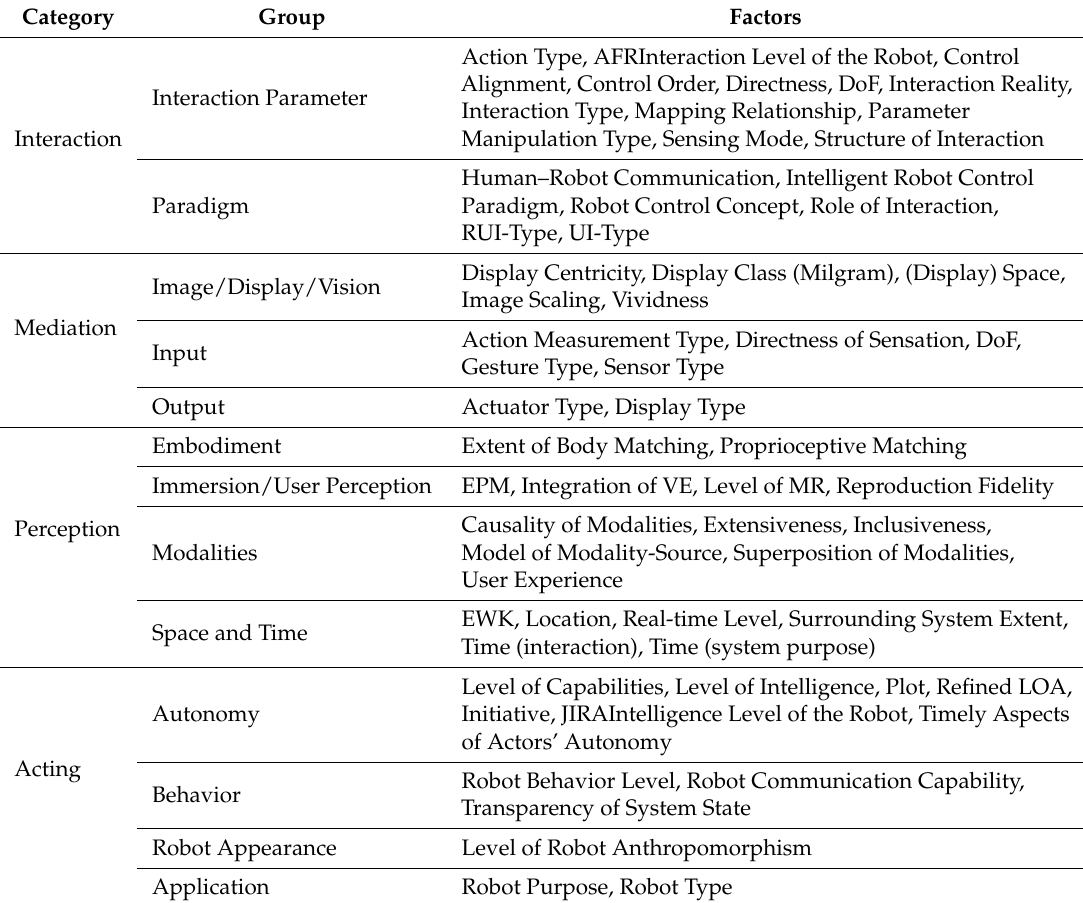
Table 1. Results of the card